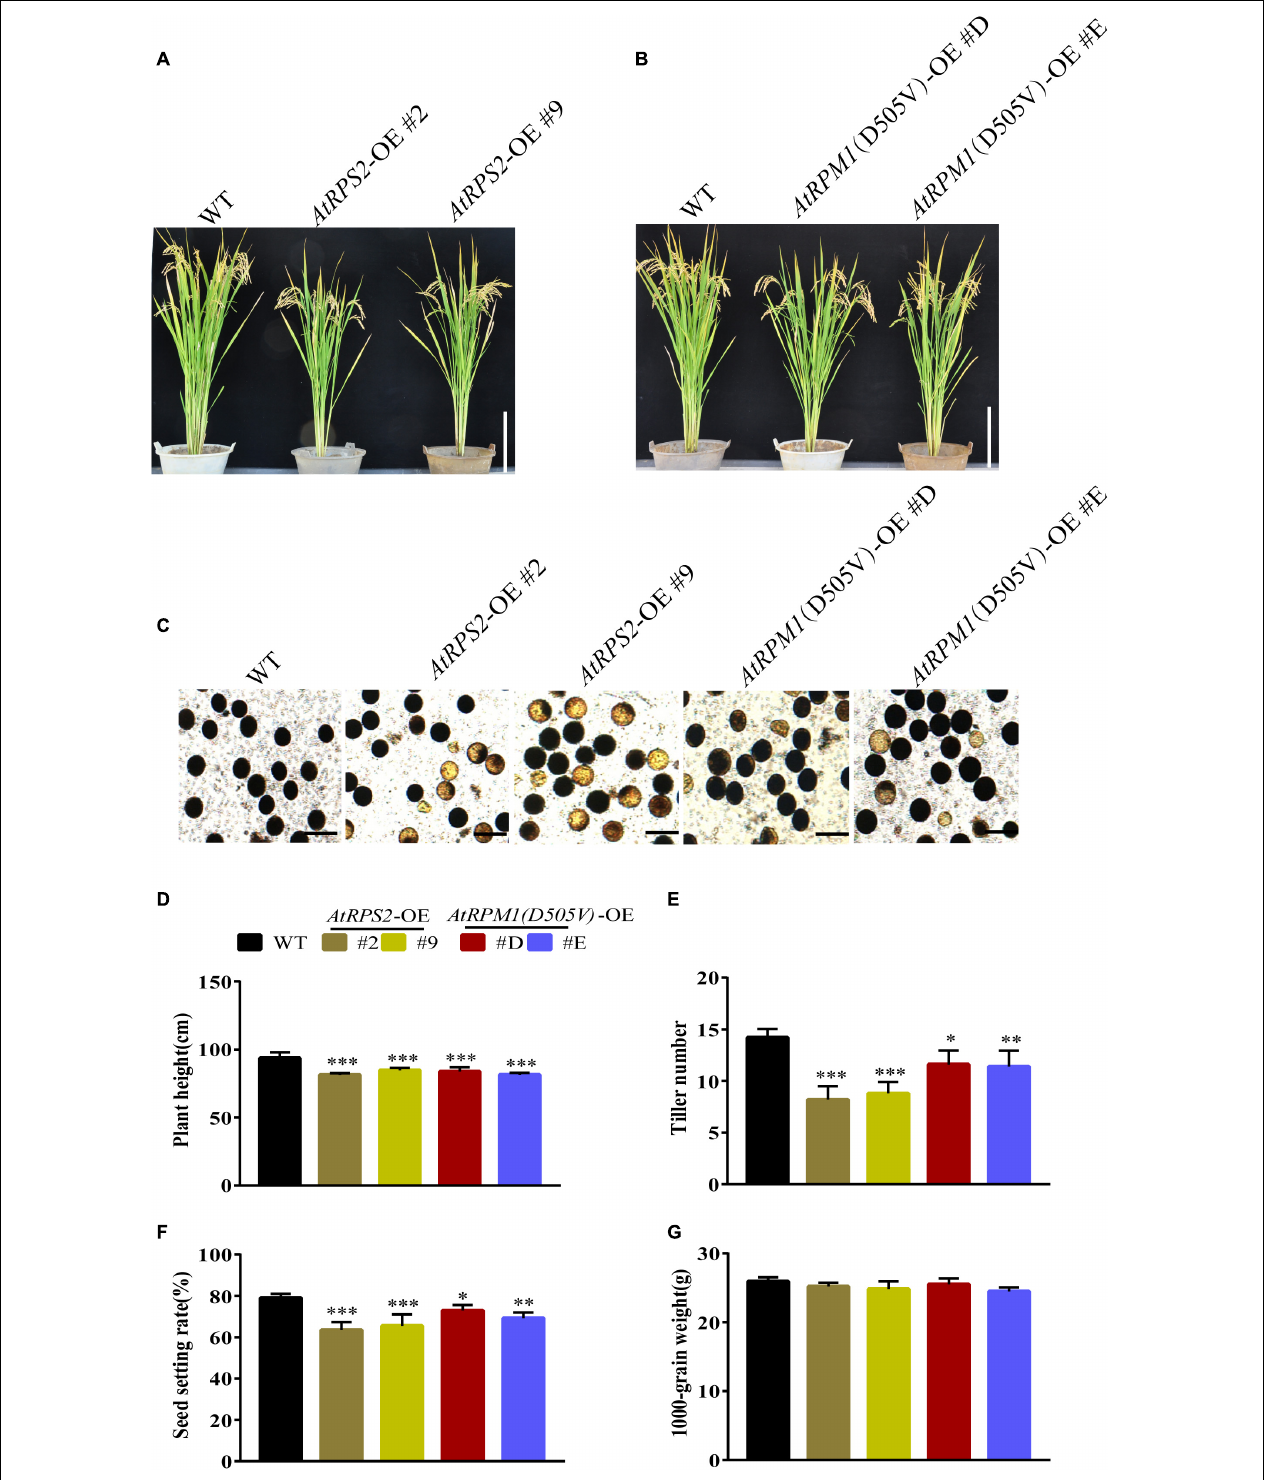
FIGURE 9 | Phenotypes and agronomic traits of the AtRPS2 , AtRPM1 ( D505V ) transgenic plants and Nipponbare plants. (A,B) The morphological phenotypes of AtRPS2, AtRPM1(D505V) transgenic plants and Nipponbare. (C) Comparison of pollen fertility between the transgenic plants and Nipponbare plants. The heavily stained pollen is fertile and the lightly stained pollen is infertile. (D–G) Plant height (cm), tiller numbers per plant, seed setting rate, and 1000-grain weight. Data are shown as means ± SD ( n = 6). Asterisks represent significant differences (one way ANOVA, ∗ P < 0.05, ∗∗ P < 0.01, ∗∗∗ P < 0.001).